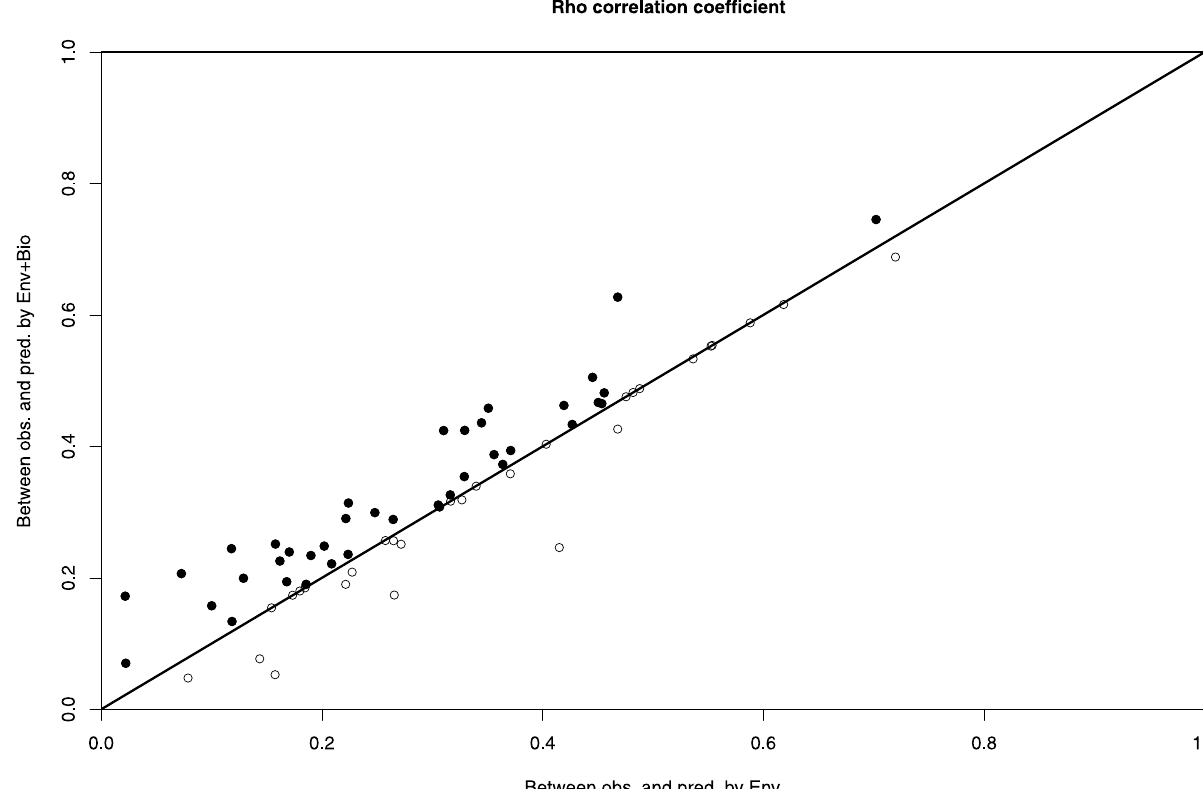
Fig 2. Correlation between the prediction of “Env” and “Env + Bio” models. Rho coefficient of the correlation between the observed species abundances and abundances predicted by “Env+Bio” vs. the correlation coefficient between abundances observed and predicted by “Env” models, for the 68 species. Black points above the line represent species with higher Spearman’s rho correlation coefficients values using “Env+Bio” rather than “Env” predictors. The opposite is true for white points below the line.